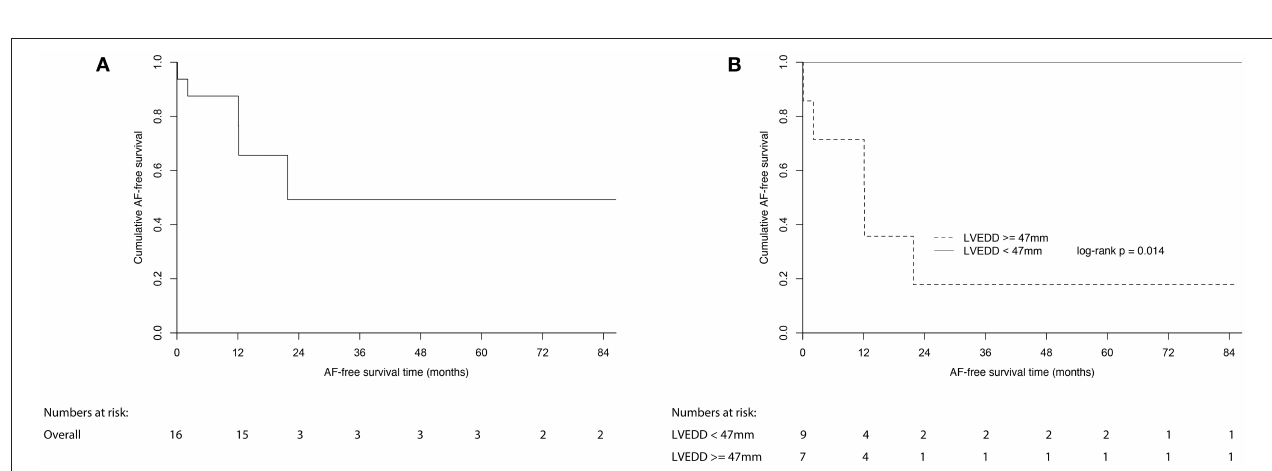
FIGURE 3 | Estimated AF-free survival of (A) all patients with AF underwent ablation; (B) patients with AF underwent ablation divided by LVEDD of 47mm. AF, atrial fibrillation; LVEDD, left ventricular end-diastolic dimension.